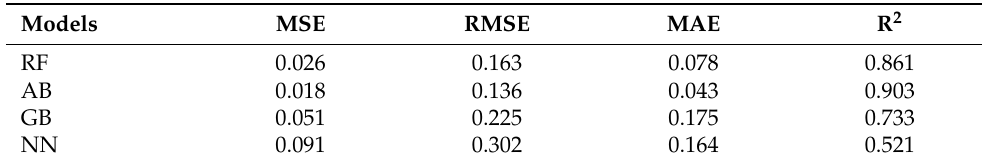
Table 5. Performance measurement values of ML